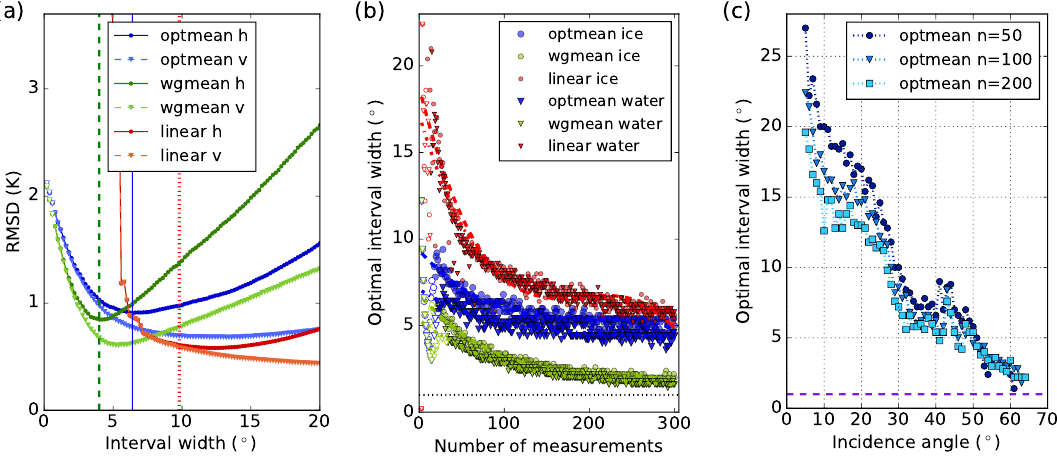
Figure 4. ( a ) Root mean sqared differences (RMSD) between modeled and fitted brightness temperatures (TBs) as a function of interval width for θ 0 = 40 ◦ and n = 60 over sea ice. The vertical lines indicate the optimal interval widths ∆ θ for the different methods; ( b ) optimal interval widths for different numbers of measurements n over sea ice and water for θ 0 = 40 ◦ . Open symbols indicate more than 2% of missing data; ( c ) optimal interval widths for different incidence angles for the optmean method over sea